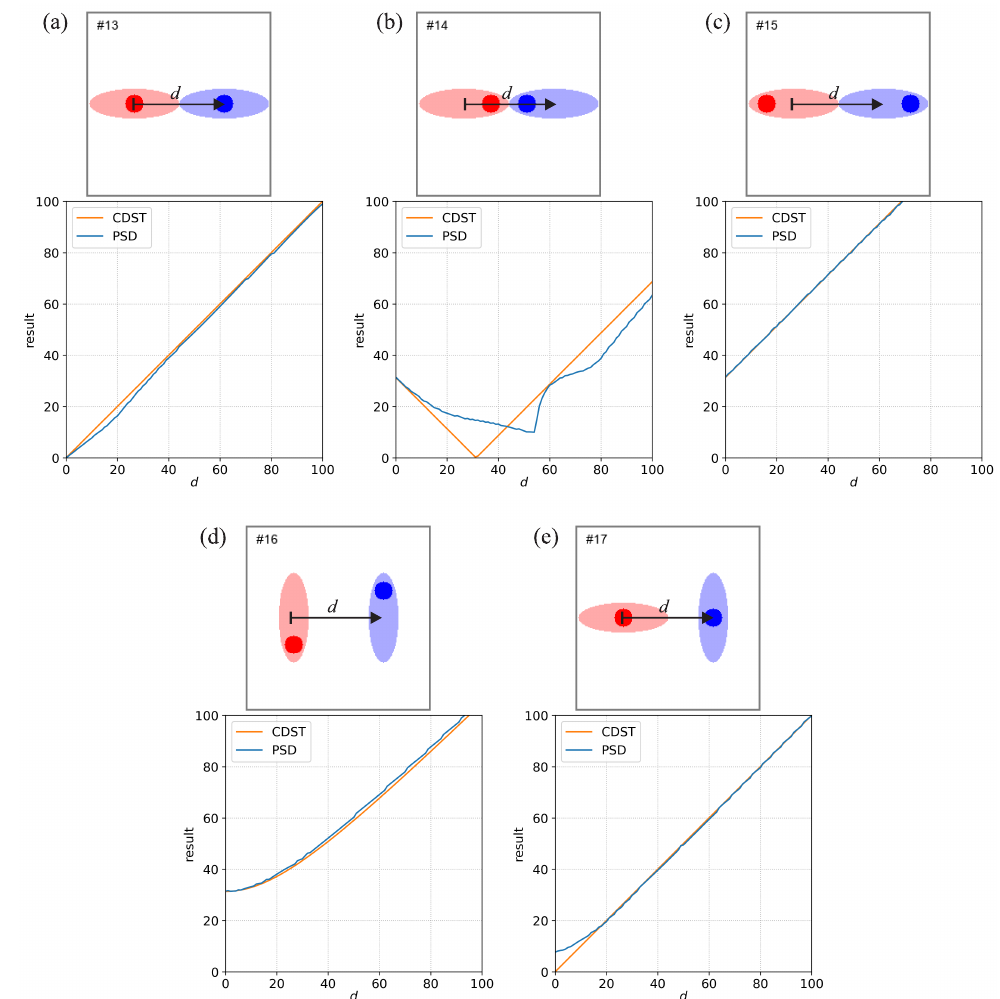
Figure 3. Same as Figure 1 but for the six comparisons that use a set of displaced double-level events. The area with low-intensity values is elliptical but contains a smaller circular area with high-intensity